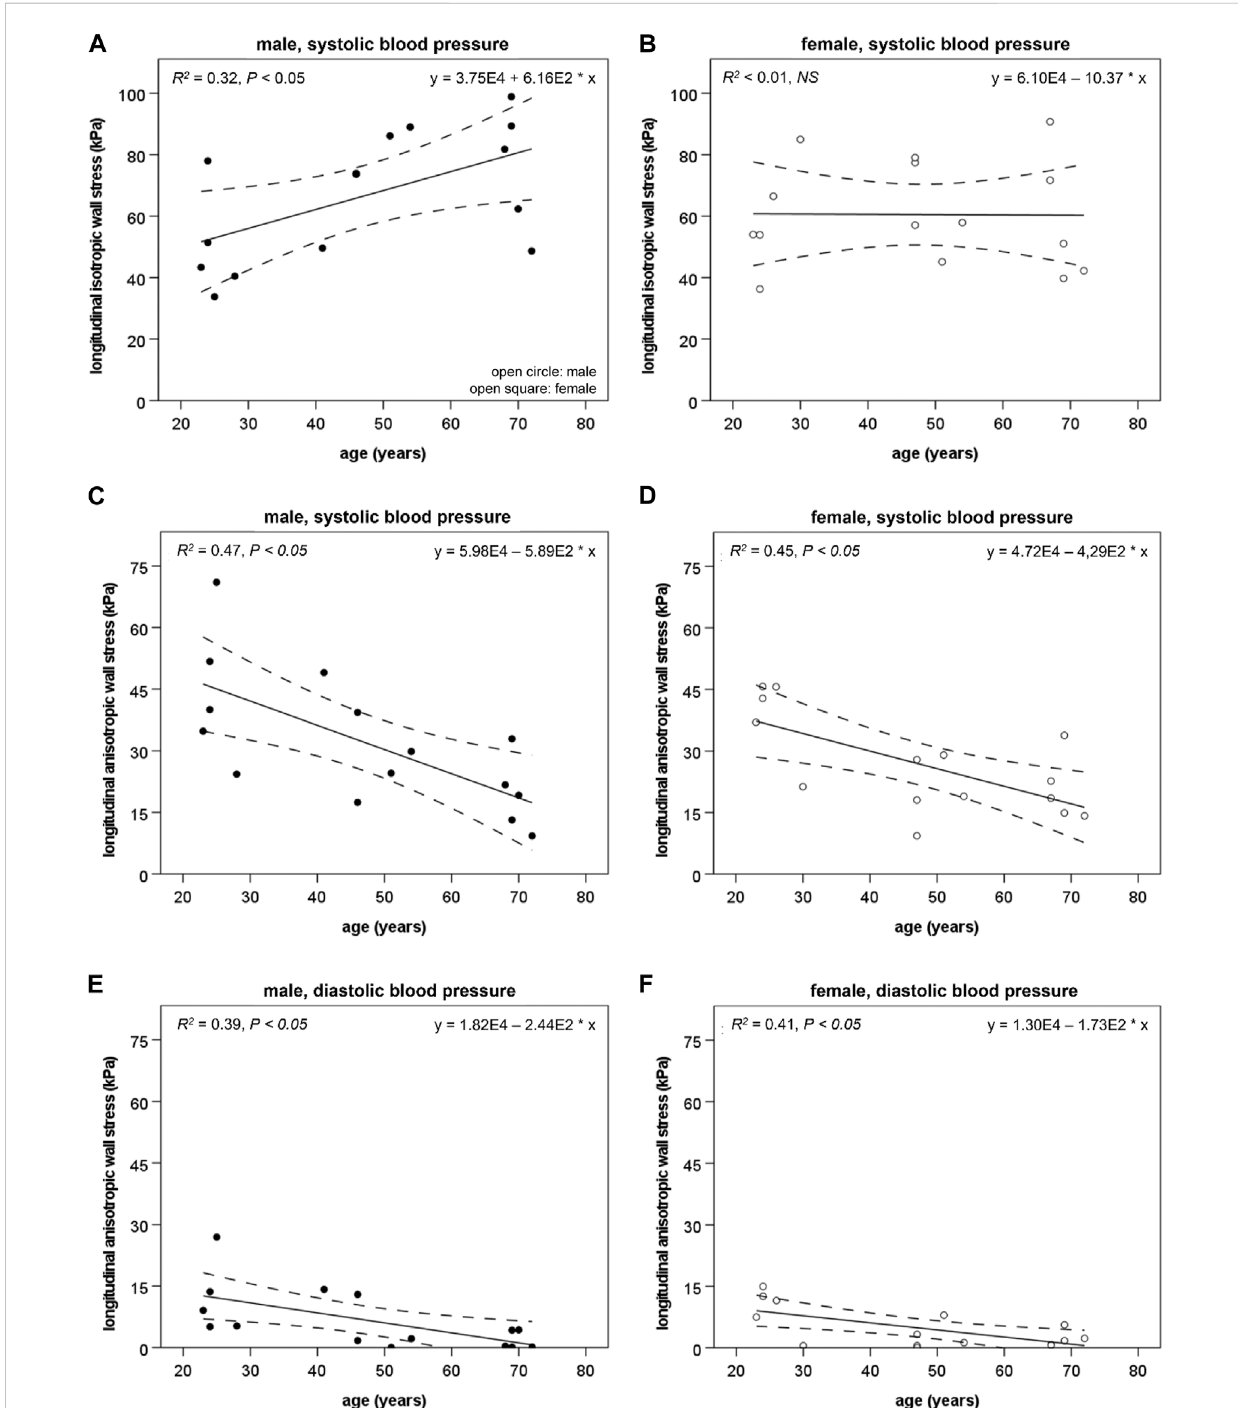
FIGURE 4 The longitudinal isotropic wall stress component ( σ iso z ) is depicted at systolic blood pressure (SBP) in the male (A) and female (B) abdominal aorta. In males, σ iso z increases with age ( R 2 = 0.32, p < 0.05), while in females, σ iso z and age did not correlate ( R 2 < 0.01, NS). The longitudinal anisotropic wall stress component ( σ aniso z )isshown atSBP and diastolic bloodpressure(DBP) for theabdominal aorta inmales (C, E) and females (D, F) . σ aniso z decreases inmales andfemalesatSBP( R 2 =0.47, p < 0.01and R 2 =0.45, p < 0.01,respectively)andDBP( R 2 =0.39, p < 0.05and R 2 =0.41, p < 0.01,respectively).Dashed lines mark a 95% con fi dence